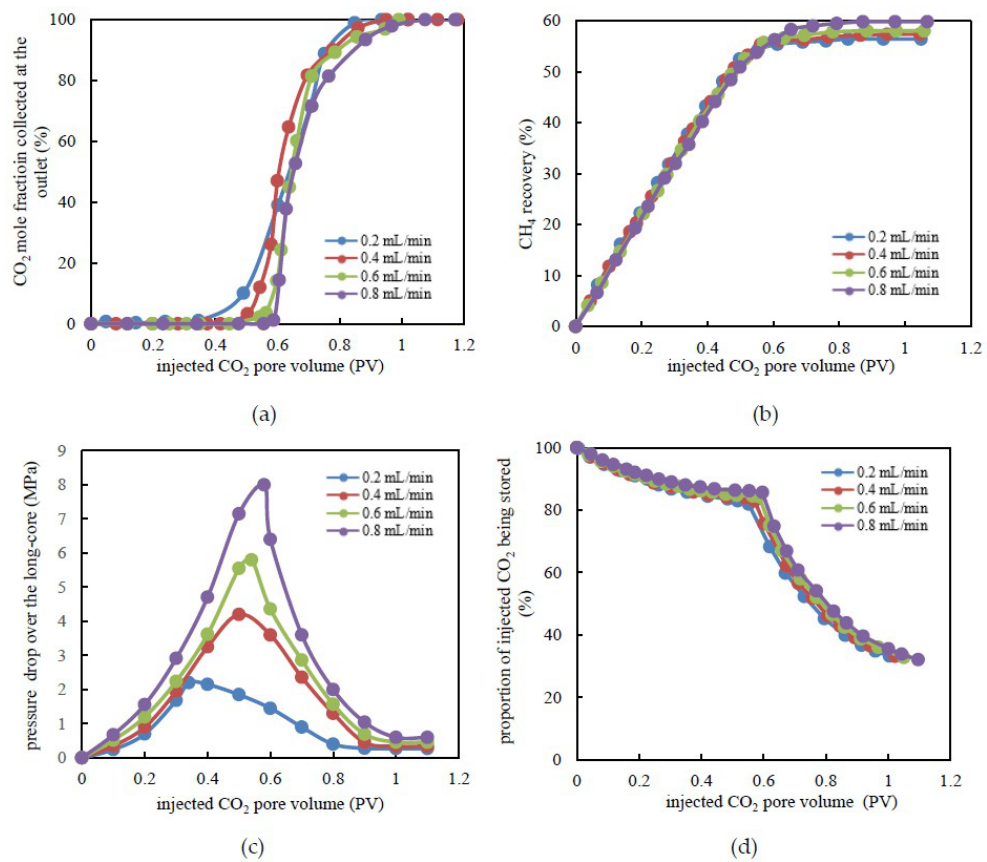
Figure 3. Experimental results under various injection rates. ( a ) CO 2 mole fraction at the outlet versus injected CO 2 pore volume. ( b ) CH 4 recovery by CO 2 flooding. ( c ) Pressure drop over tight long-core versus the pore volume during CO 2 flooding. ( d ) The proportion of injected CO 2 being stored versus an injected CO 2 pore volume.